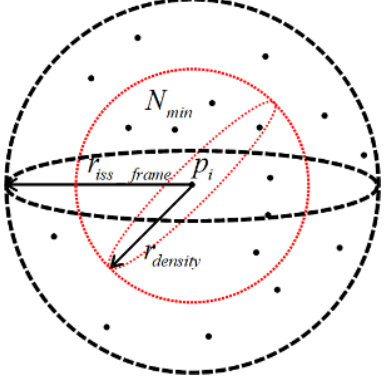
Figure 3. Schematic of intrinsic shape signatures (ISS).